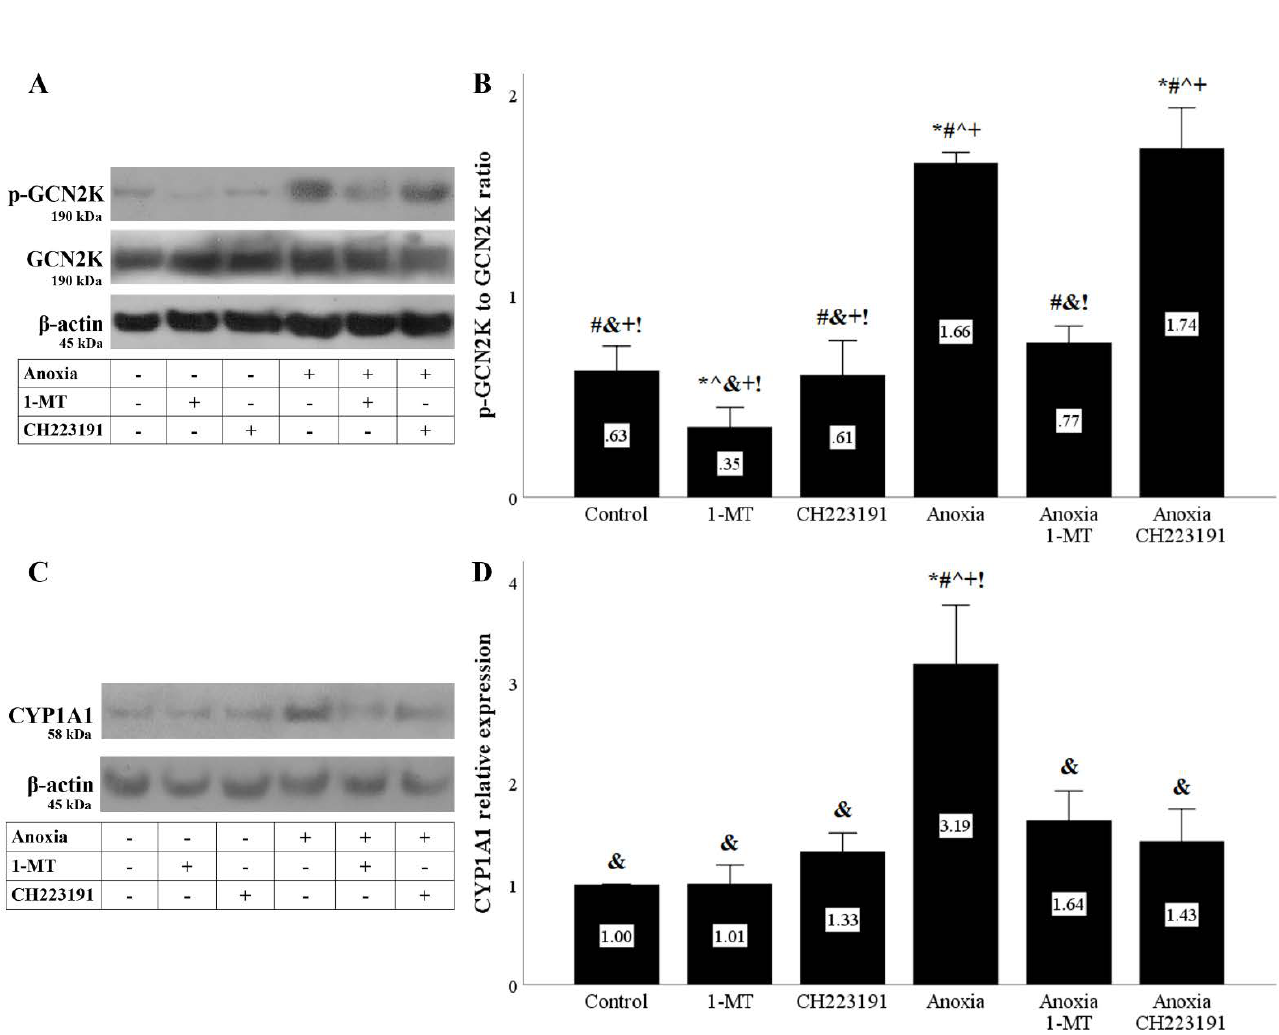
Figure 3. Anoxia activates both IDO activity-derived pathways. Cells were cultured under anoxic conditions for 24 h along with the indicating treatments. Anoxia activated the GCN2K pathway assessed by the level of phosphorylated activated GCN2K. 1-MT, but not CH223191, prevented GCN2K activation. A representative Western blot experiment is displayed in panel ( A ), whereas panel ( B ) depicts the cumulative results of four repeated experiments. Anoxia activated the AhR pathway assessed by the level of the AhR transcriptional target CYP1A1. Both the IDO inhibitor 1-MT and the AhR inhibitor CH223191 prevented AhR activation. A representative Western blot experiment is displayed in panel ( C ), whereas panel ( D ) depicts the cumulative results of four repeated experiments. * p < 0.05 vs. Control, # p < 0.05 vs. Control with 1-MT, ^ p < 0.05 vs. Control with CH223191, & p < 0.05 vs. Anoxia, + p < 0.05 vs. Anoxia with 1-MT, ! p < 0.05 vs. Anoxia with CH223191. Error bars correspond to SEM. 1-MT, 1-DL-methyltryptophan; CYP1A1, cytochrome P450, family 1, subfamily A, polypeptide 1; GCN2K, general control nonderepressible 2 kinase; p-GCN2K, phosphorylated GCN2K.